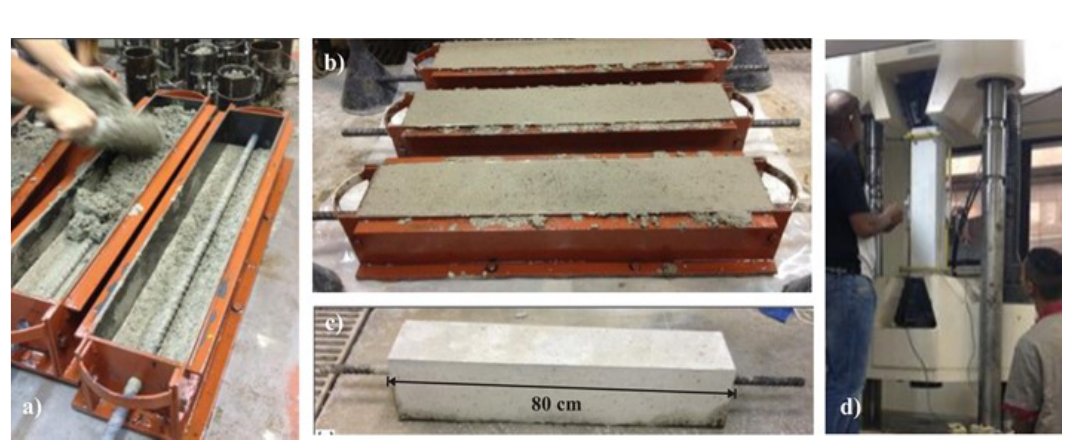
Figure 3. Production and tension stiffening test: a) casting of concrete; b) end of molding; c) test specimen; d) positioning the testing